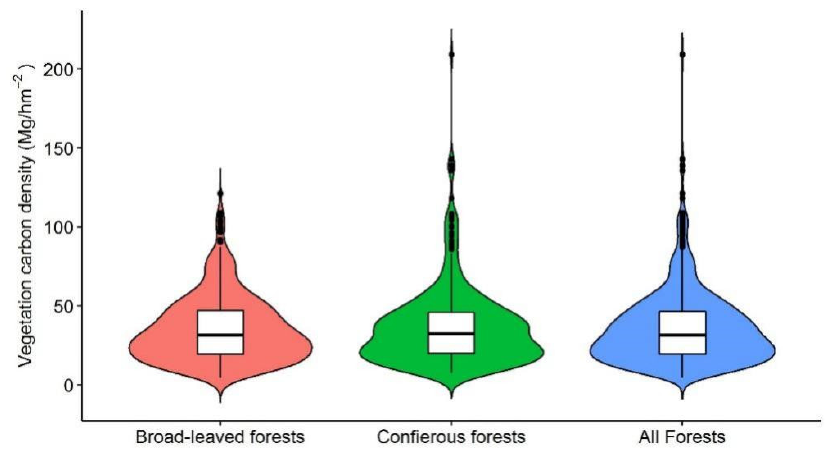
Figure 2. The kernel density estimation of natural broad-leaved and coniferous forests biomass carbon density in Shanxi, China.